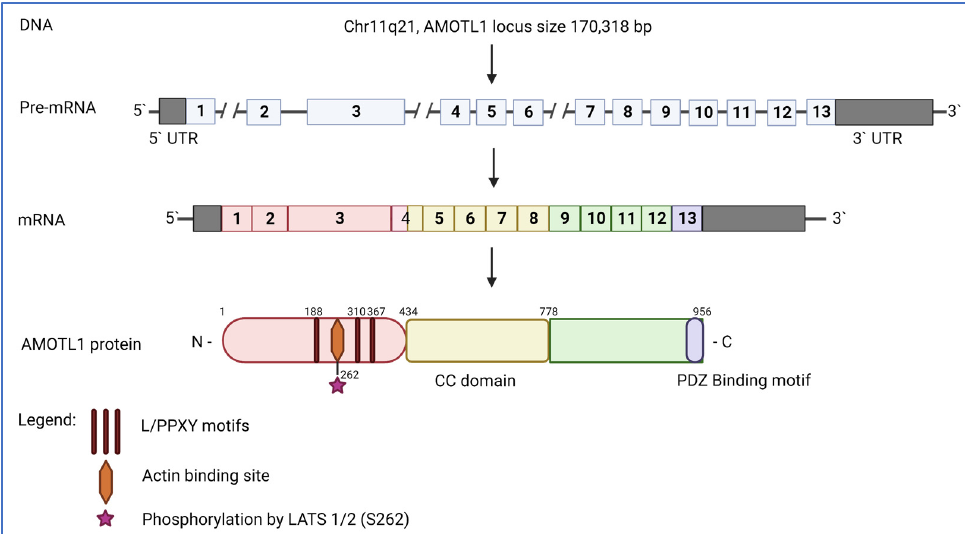
Figure 1. Schematic representation of AMOTL1 gene, mRNA, and protein. AMOTL1 locus, located on chromosome 11q21 of the human genome, comprises 13 exons. AMOTL1 protein contains L/PPXY motifs, an actin-binding site, and a phosphorylation site modified by LATS1/2 within the ID domain (orange). The coiled-coil domain is located in the middle part (yellow) and is followed by a C-terminal fragment (green) containing the PDZ-binding motif